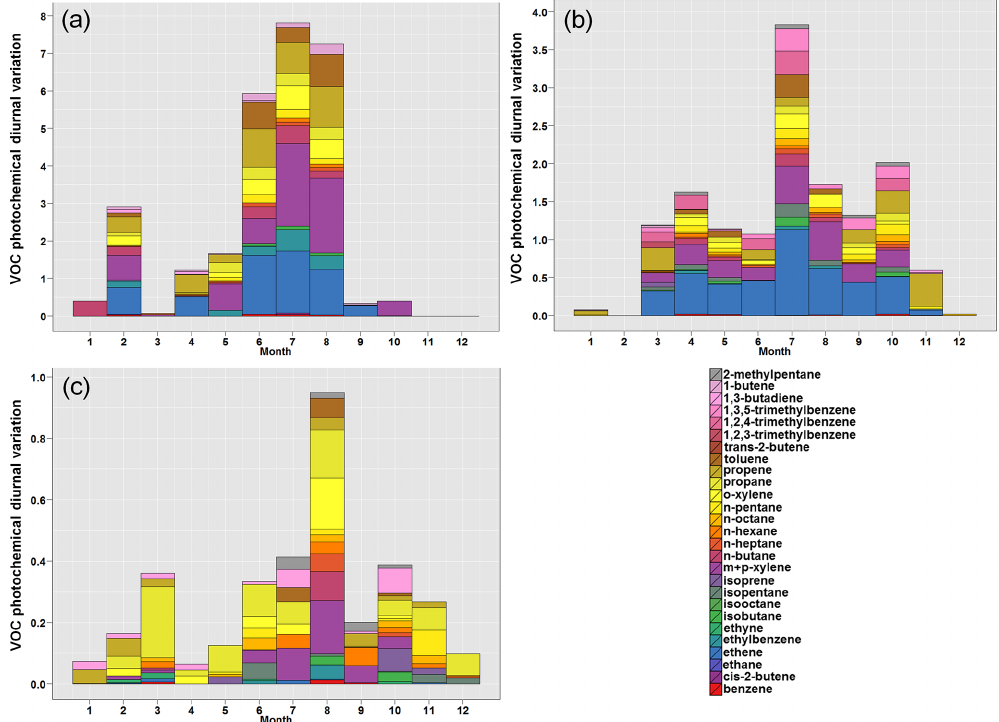
Figure 6. Monthly variation in VOC diurnal photochemical reactivity as defined by the difference between night (average of 01:00–05:00) and afternoon (13:00–17:00) POCP-weighted VOC / ethane ratios for (a) Harwell 2001, (b) Harwell 2011, and (c) Auchencorth 2011. Note the very different vertical